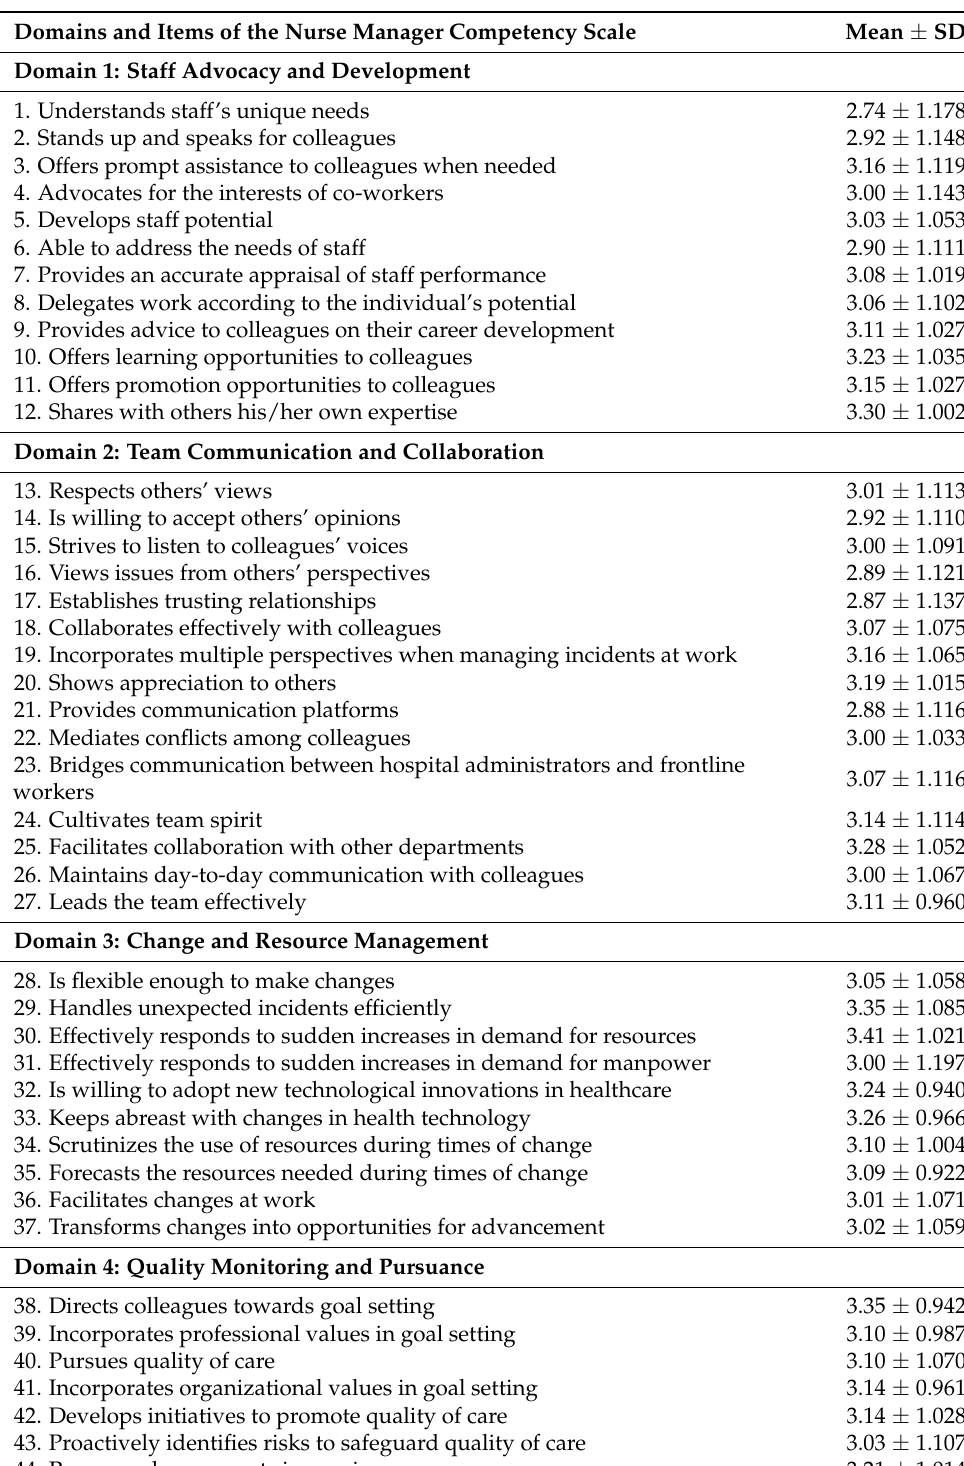
Table 3. The level of nurse manager competencies ( N =